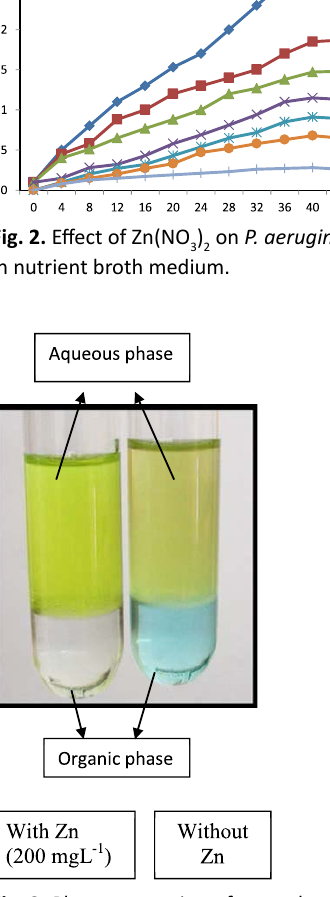
Fig. 3. Phase separation of secondary metabolites and biosynthesis of ZnONPs.